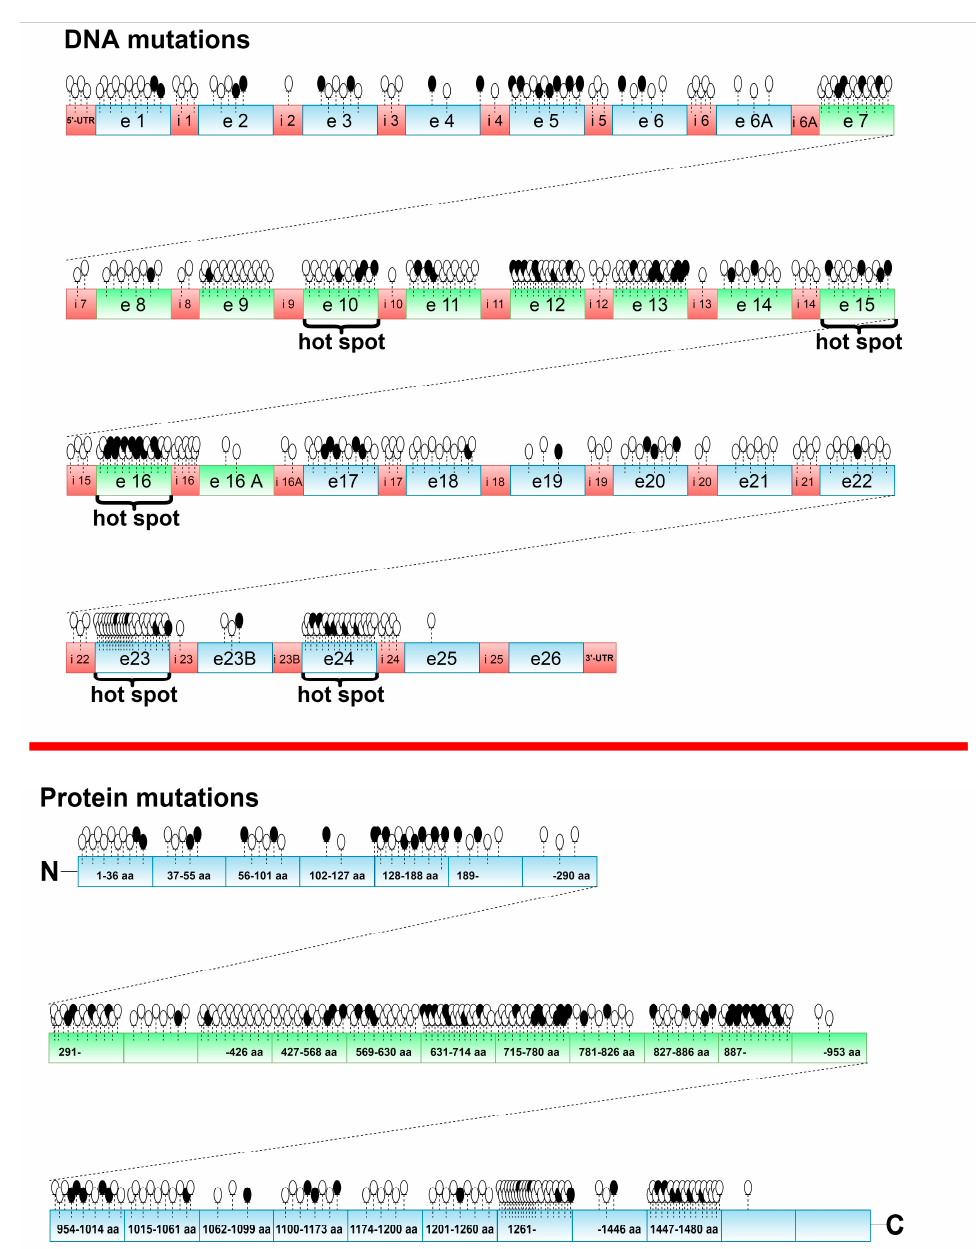
Figure 4. TCOF1 polymorphisms and mutations detected in patients with Treacher Collins syndrome (TCS) and described thus far in the literature. The exonic/intronic localization of mutations ( upper panel ) refers to data provided in Table S1. The localization of the corresponding amino acids ( lower panel ) is based on NCBI Reference Sequence: NP_001128715.1. Each pin represents one genetic change. Black pins indicate changes that result in a truncated protein. Detailed characteristics of the mutations are provided in Table S1.